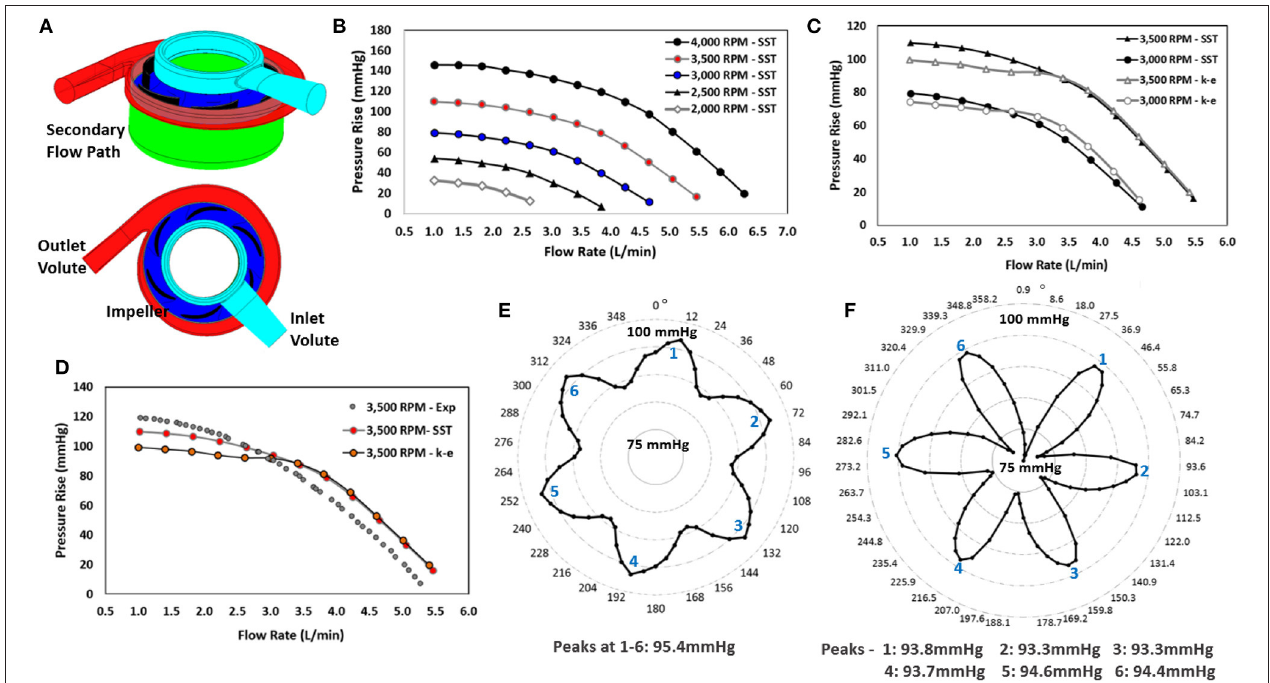
FIGURE 4 | Computational modeling: (A) Model with regions labeled, (B) Pressure-flow performance curves for operating conditions of 3,000 to 4,000 RPM at flow rates of 1 to 6 L/min for the SST turbulence model, (C) Comparison of pressure-flow performance curves for the SST and k-epsilon turbulence models for operating conditions of 3,000 to 4,000 RPM at flow rates of 1 to 5 L/min , (D) Qualitative comparison of experimental hydraulic data for the 3,500 RPM operating speed with the computational predictions of the k-epsilon and SST turbulence models, (E) Pressure rise across the centrifugal pump using a quasi-steady analysis, (F) Pressure rise across the centrifugal pump using TRSI